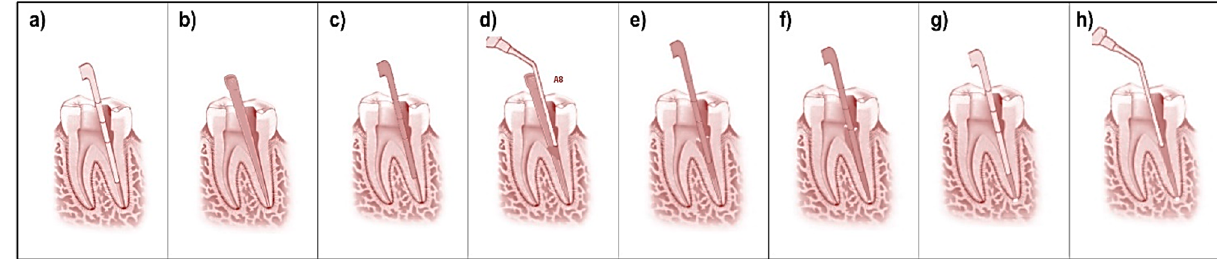
Figure 7. Scheme of successive stages of the original thermo-hydraulic condensation technique: ( a ) a Dovgan plugger is fit to 3–5 mm of the working length after appropriate root canal preparation; ( b ) a non-standarised gutta-percha cone is fitted 1 mm short of the working length; ( c ) a Buchanan plugger is prefitted in the canal to bind within 4–7 mm from the apical terminus; ( d ) using the tip of the Obtura gun, thermoplasticized gutta percha is injected into the canal and the head of the cone is seared off at the orifice; ( e ) the Buchanan plugger (preheated to 100 °C) is driven into the gutta-percha until resistance is felt; ( f ) the System B apical is applied to the plugger until binding resistance is felt after the temperature is raised to 300 °C (the plugger is then immediately withdrawn); ( g ) to condense the thermosoftened gutta-percha, an up/down motion is used with the prefitted Dovgan plugger with firm pressure for 10 s as the material cools; ( h ) the obturation is completed using the Obtura gun by backfilling the canal.